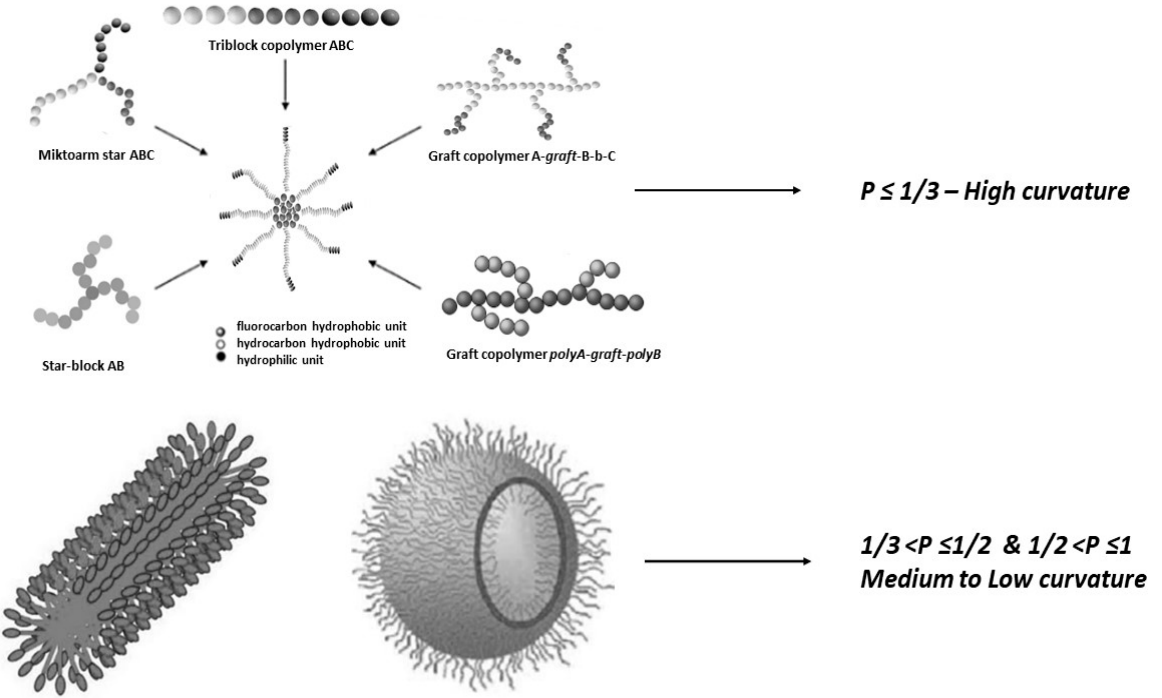
Figure 2. Block copolymer self-assembled nanostructures based on the hydrophilic/lipophilic balance of individual chain polymers, ranging from spherical and cylindrical micelles to vesicles.